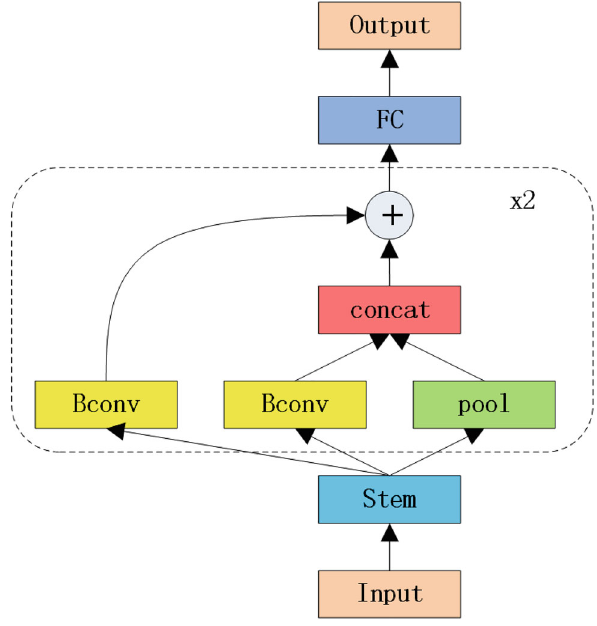
Fig. 5 The structure of BCNN